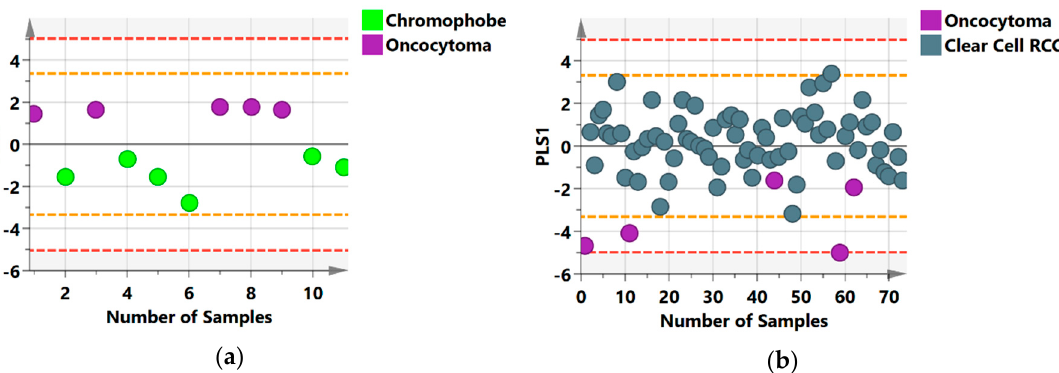
Figure 3. NMR Orthogonal Partial Last Squares Discriminant Analysis (OPLS-DA) score scatter plots distinguishing between histology subtypes ( a ) chromophobe versus oncocytomas cases; ( b ) oncocytomas versus ccRCC cases along their partial least squares component (PLS1). The orange and red dashed lines describe the 2SD and 3SD limits respectively.